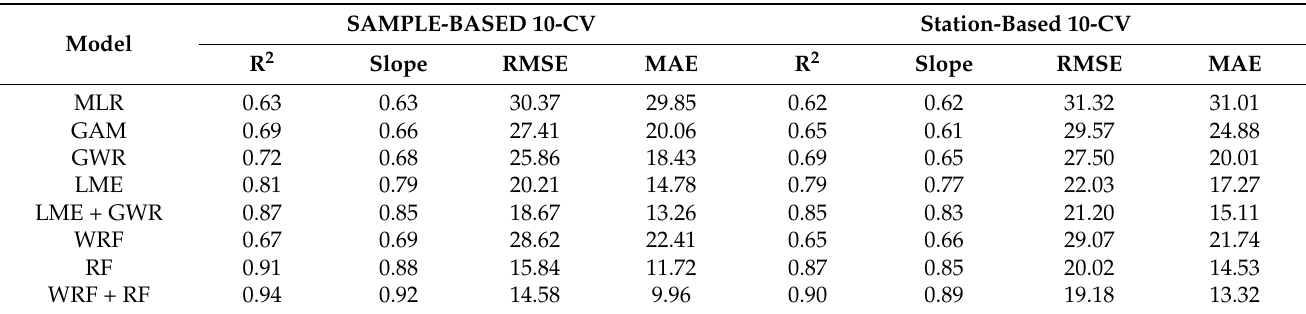
Table 1. Comparison of the model performances between our two-stage model and other widely used traditional model used in air pollutant concentration